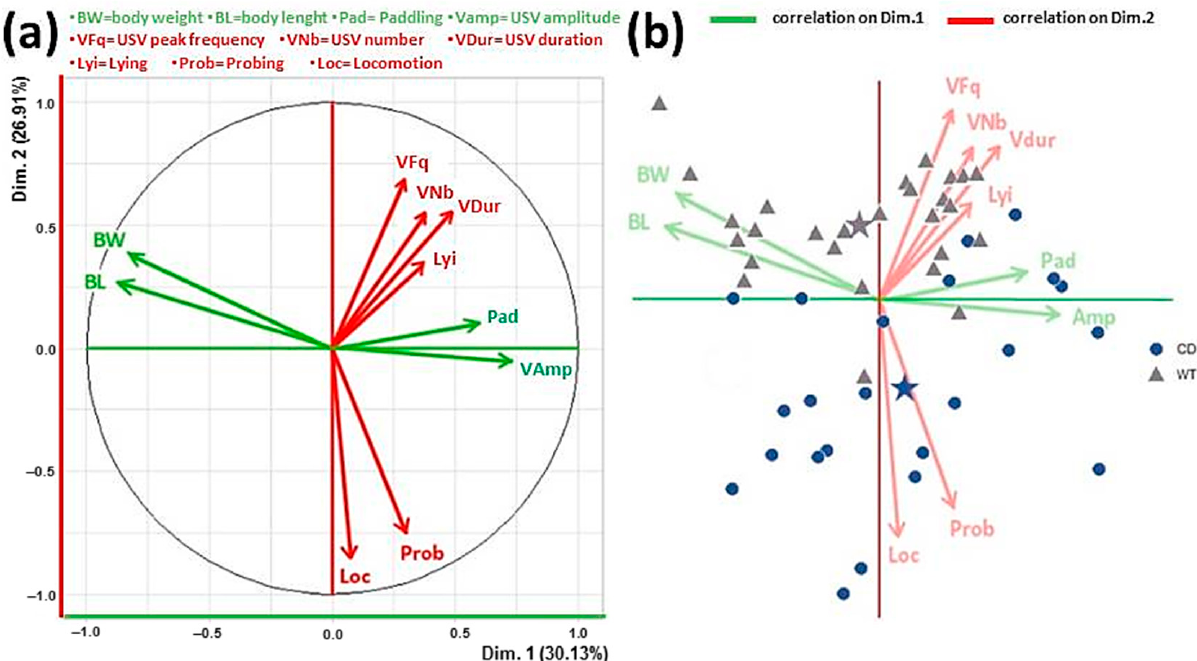
Figure 5. Principal component analysis (PCA) of pup data. Factorial plane ( a ) representing axes 1 (horizontal) and 2 (vertical). Data illustrated here were obtained only on PND 11, i.e., when the higher variability emerged, but they were confirmed by PCA performed on all other testing days. The horizontal axis was mainly correlated with morphological data (weight and length; ( a )-left) which were negatively correlated with paddling behavior and vocalization peak amplitude (( a )-right). The vertical axis was correlated with locomotion and probing behaviors (( a )-down) which were negatively correlated with vocalization peak frequency, duration, and number (( a )-up). Lying belonged to the latter cluster of variables and was unsurprisingly negatively correlated with locomotion and probing. Representation of data points from all mice on the variable space ( b ). Stars indicate the barycenter of the data clouds from subjects of the two genotypes. Panel b shows the effects of CD mutation, confirming the results of the ANOVAs on the single variables. The discrimination between the two genotypes occurred along the second axis (dimension 2), CD mice being characterized by lower body weight and length, less and shorter USVs with lower peak frequency, displaying less locomotion and